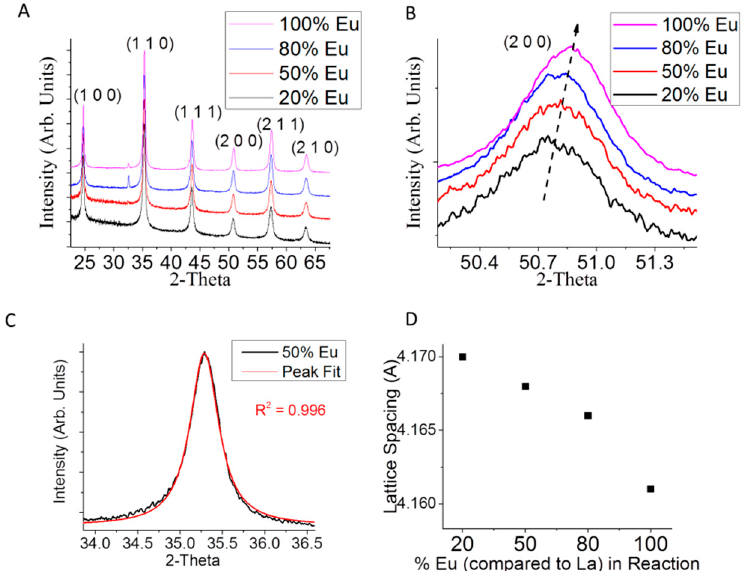
Figure 1. X-ray diffraction of ( A ) La x Eu 1 − x B 6 ; ( B ) a magnified image of the (2 0 0) diffraction plane with La x Eu 1 − x B 6 where x = 0.0, 0.2, 0.5 and 0.8; ( C ) Pearson VII peak fit of La x Eu 1 − x B 6 with x = 0.5; and ( D ) lattice spacing versus atomic % Eu in the La x Eu 1 − x B 6 reaction (calculated using Bragg ′ s law).